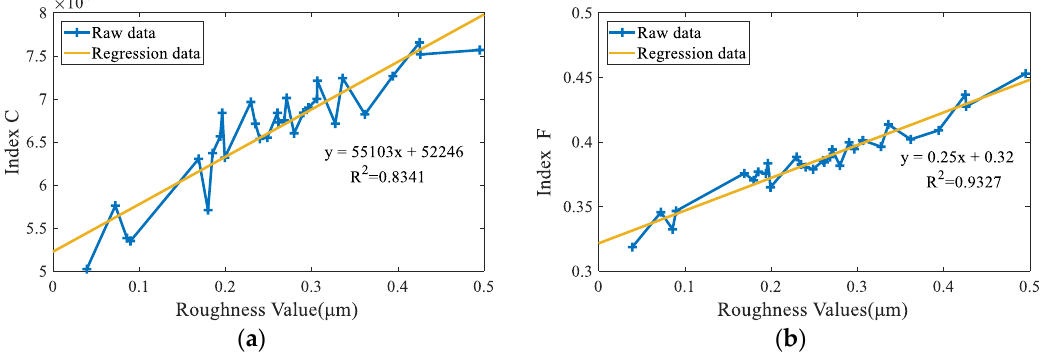
Figure 18. Raw data and regression data. ( a ) FCM_NNS-based C index ( b ) FCM_NNS-based F index.